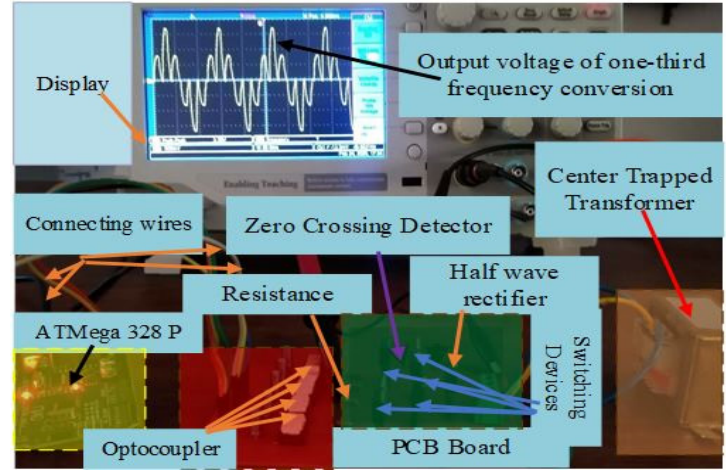
Figure 15. Physical experiment setup of the proposed cycloconverter controlling the voltage of resistive load.